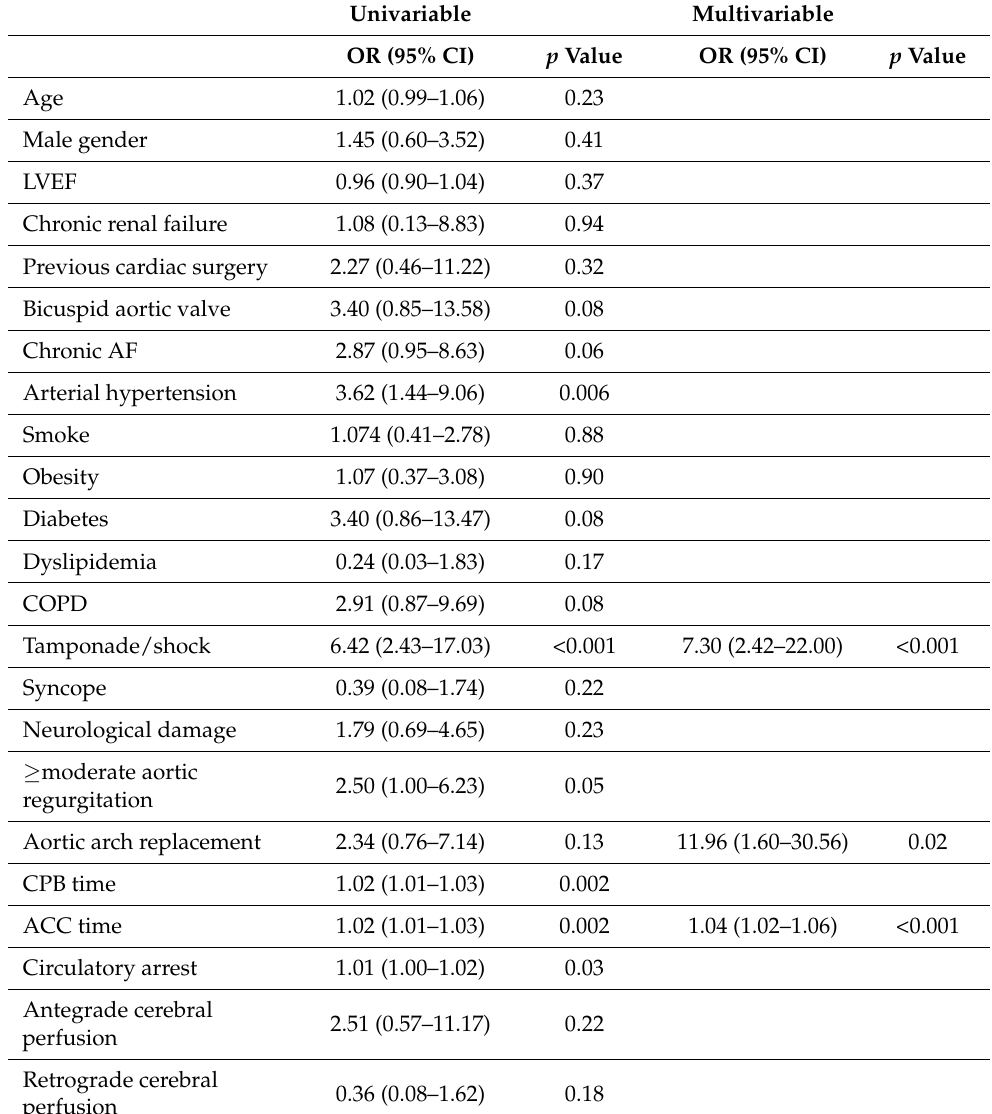
Table 5. Univariable and multivariable logistic regression analysis of baseline covariates associated with 30-day